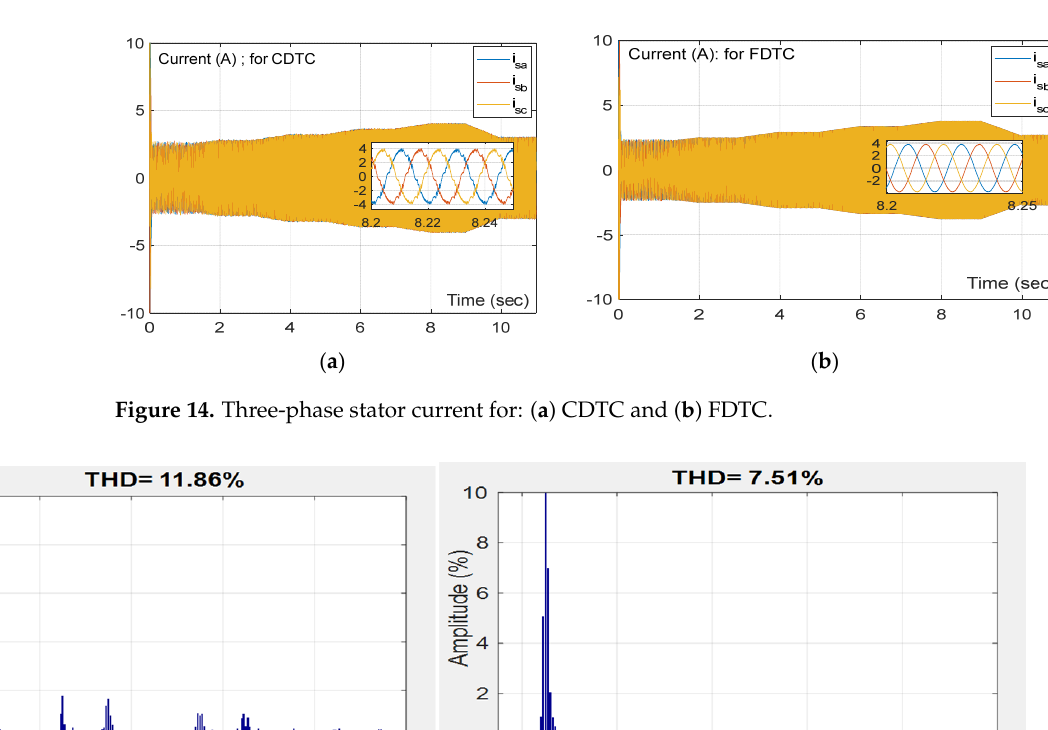
Torque ripples (Nm)